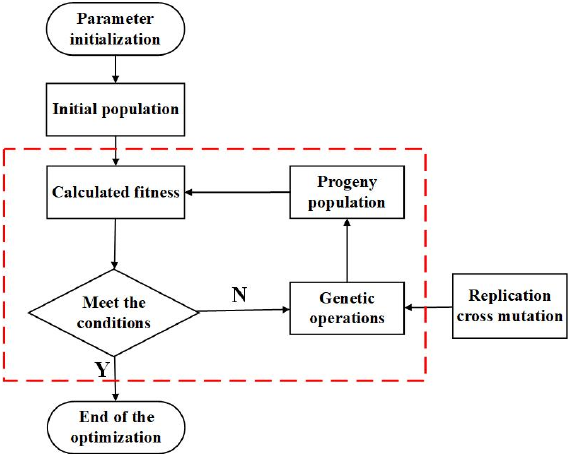
Figure 2. Flow chart of genetic algorithm. (The cyclic process of optimizing parameters is reflected in the red dotted box in the figure).